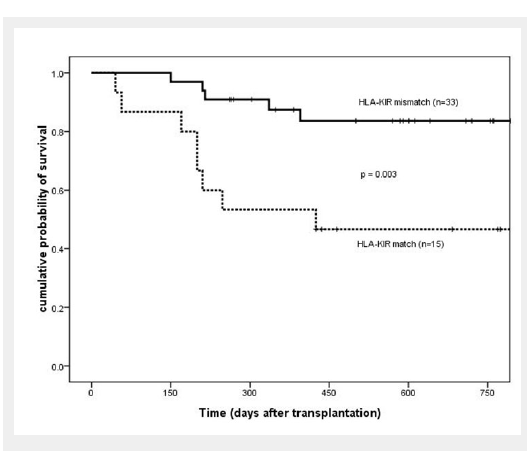
Disease-free survival of patients based on HLA-Cw ligand groups (C1 or C2 homozygote vs C1/C2 heterozygote). HLA = human leukocyte antigen.